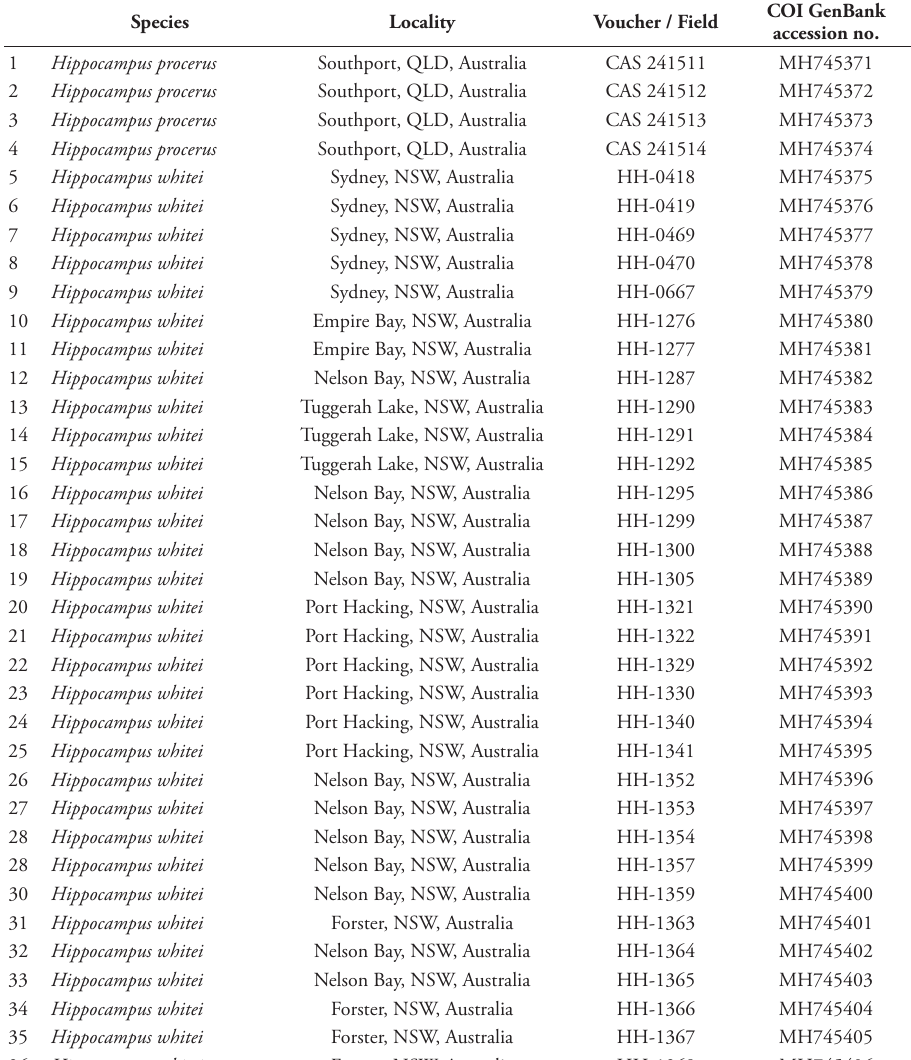
Table 1. List of H. whitei specimens, and those referred to as H. procerus , including collection locality, voucher or field number, and COI GenBank accession